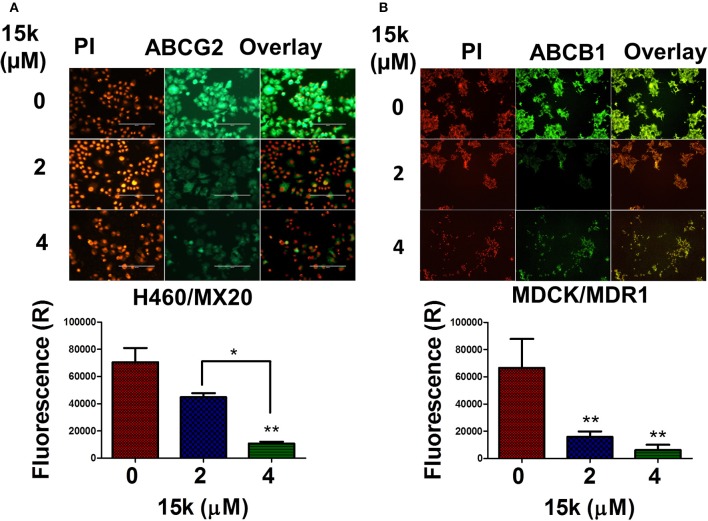
The effect of 15k on the expression level of ABCG2 transporters in H460/MX20 cells and ABCB1 transporters in MDCK/MDR1 cells. (A) Representative pictures of ABCG2 fluorescence in H460/MX20 cells. (B) Representative pictures of ABCB1 fluorescence in MDCK/MDR1 cells. Below each of the protein pictures is a histogram summarizing the results where (R) is for relative. The data are presented as the means ± SEM of three independent experiments. *p < 0.05, **p < 0.01.